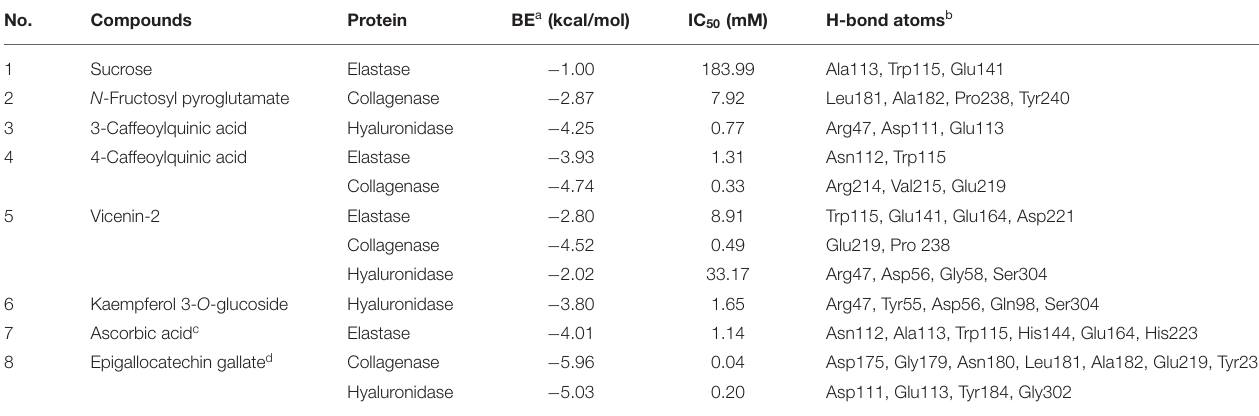
TABLE 2 | The molecular docking results of the presentative active ingredients in M. oleifera leaf extracts and positive drugs against elastase, collagenase, and hyaluronidase, respectively.